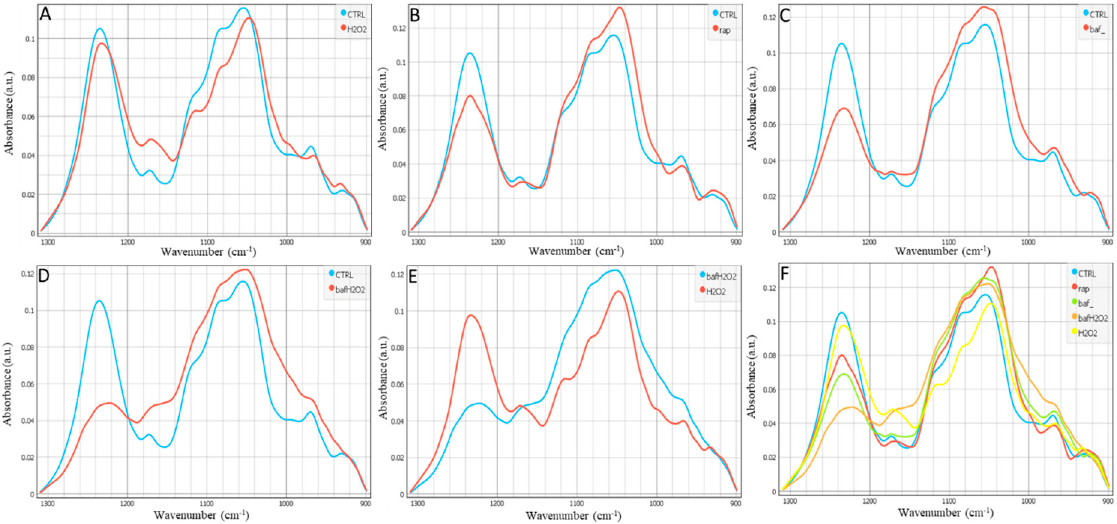
Figure 2. Average spectra of the fingerprint (nucleic acids and carbohydrates) region (890–1310 cm − 1 ) in hRPE cells: ( A ) Control vs. H 2 O 2 , ( B ) Control vs. Rap, ( C ) Control vs. Baf, ( D ) Control vs. Baf+H 2 O 2 , ( E ) Baf+H 2 O 2 vs. H 2 O 2 , and ( F ) all conditions are being shown. Representative data of the